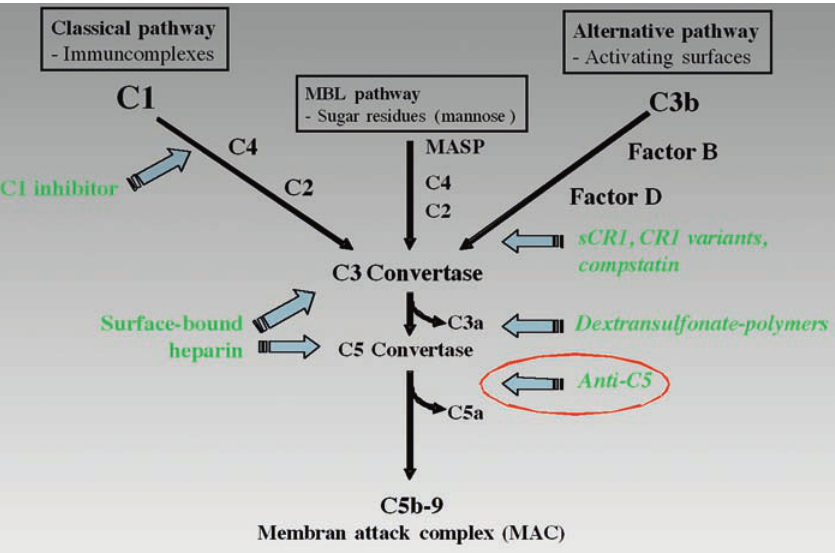
Figure 1 The complement cascade and thera- peutic complement inhibitors. The anti- C5 antibodies eculizumab and pex- elizumab (red circle) inhibit the cleavage of C5 into its frag- ments C5a and C5b. Compared to other complement in- hibitors, both anti- bodies interfere in a relatively late stage of the complement